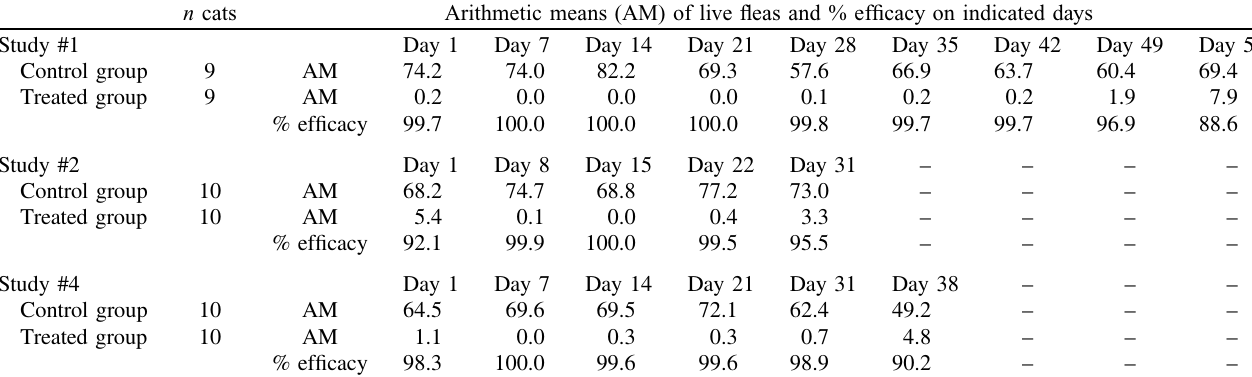
Table 4. Ctenocephalides felis adulticide ef fi cacy. n cats Arithmetic means (AM) of live fleas and % efficacy on indicated